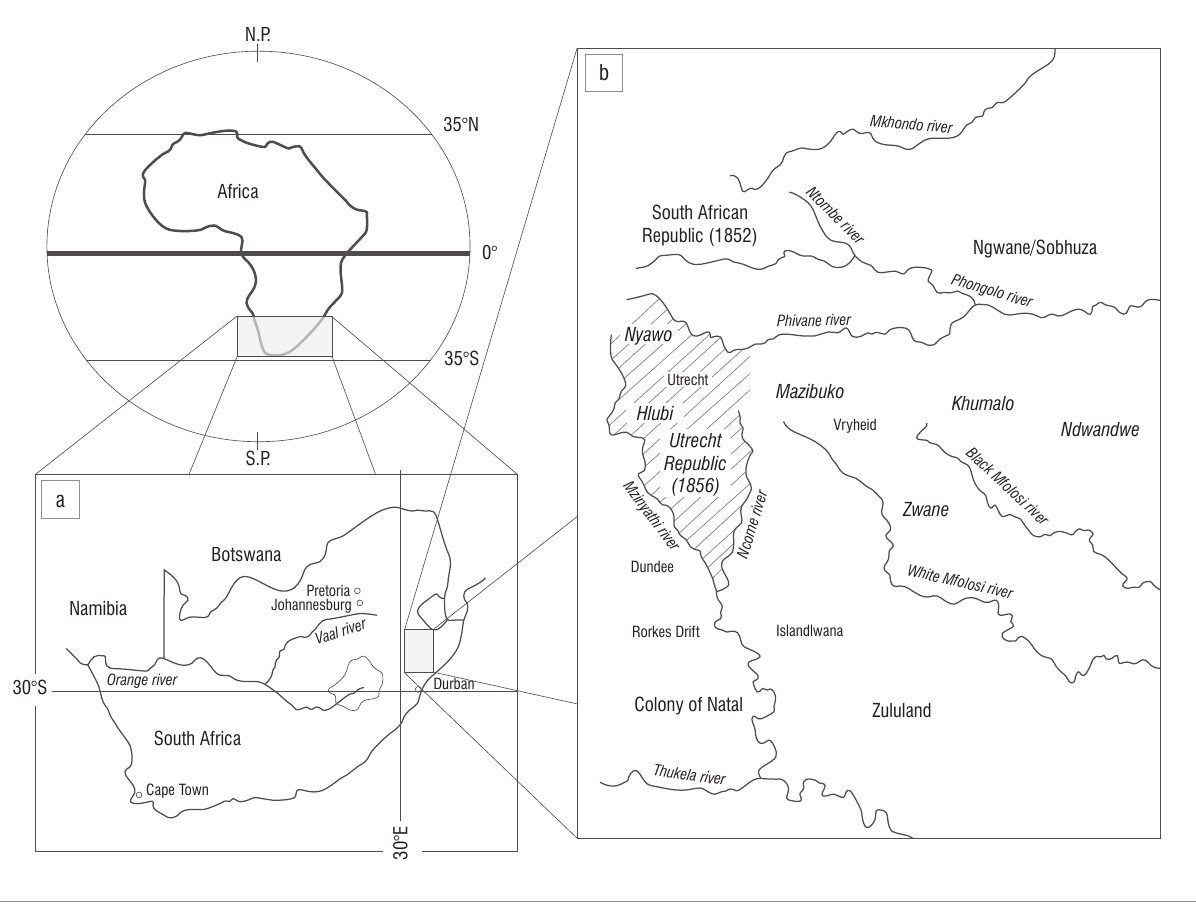
Figure 1: (a) The continent of Africa together with contemporary political boundaries and key cities, rivers and mountains of southern Africa and (b) the location of the Colony of Natal and Zululand together with tribal groups in the early to mid-19th